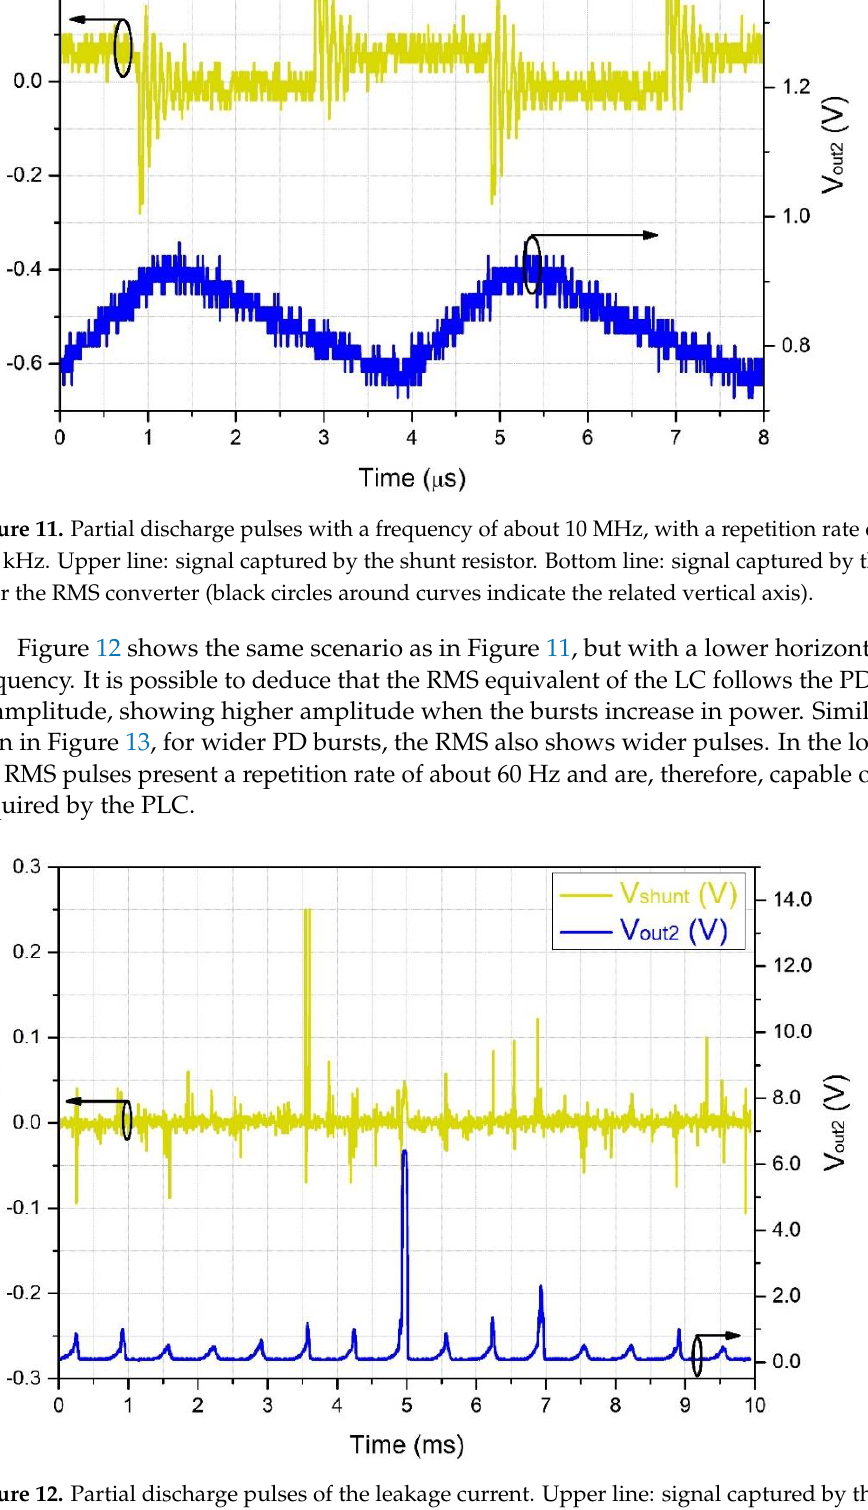
Figure 12. Partial discharge pulses of the leakage current. Upper line: signal captured by the shunt resistor. Bottom line: signal captured by the OSM after the RMS converter, showing higher amplitude when the bursts increase in power (black circles around curves indicate the related vertical axis).